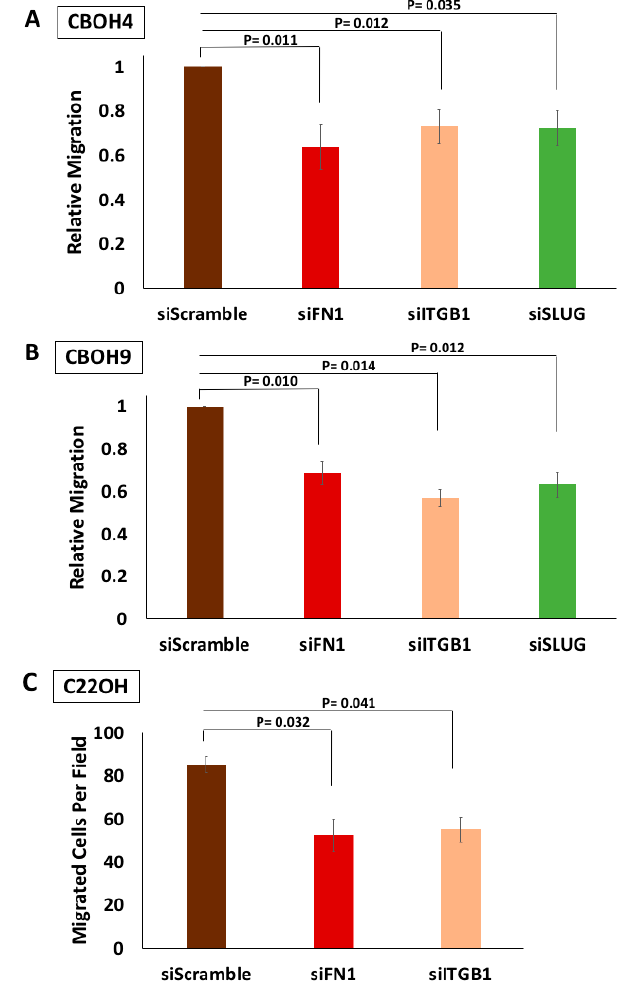
Figure 1. Circulating tumor cell (CTCs) demonstrate decreases in migration upon FN1, ITGB1, and SLUG transient knockdown. ( A ) Knockdown of FN1, ITGB1, and SLUG and their effects on CBOH4 migration. ( B ) Knockdown of FN1, ITGB1, and SLUG and their effects on CBOH9 migration. ( C ) Knockdown of FN1 and ITGB1 and their effect on C22OH migration. Transient transfections, using a final concentration of 25 pmol, were performed for a total of 12 h until wounds closed for at least one condition in CBOH4 and CBOH9. Transwell migration assays for C22OH were carried out for 24 h. All experiments were performed three times. Statistical analysis was performed using t ‐ test, where p < 0.05 was deemed